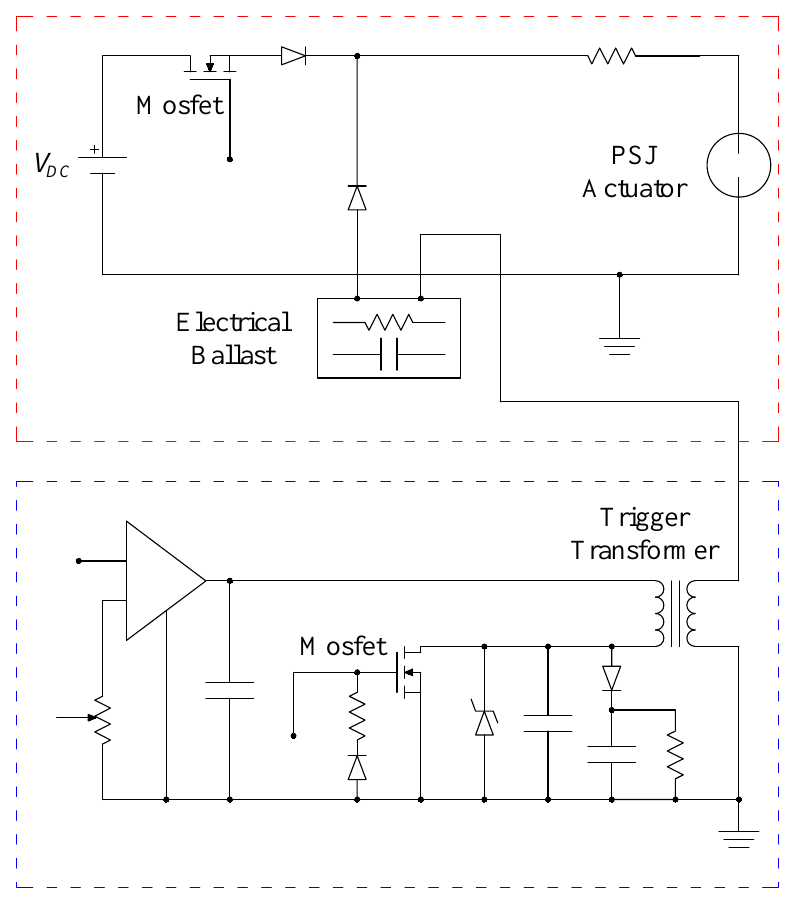
Figure 2. The power supply system: the red box contains the sustain circuit, while the blue the trigger